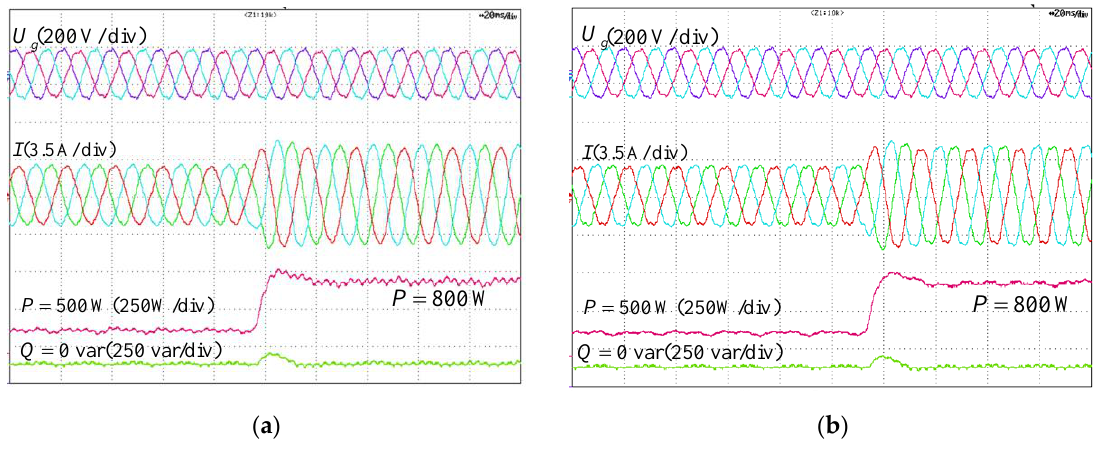
Figure 14. Power regulation of VSC under integer harmonics grid with the proposed control strategy. ( a ) Power regulation with the target I; ( b ) Power regulation with the target II.